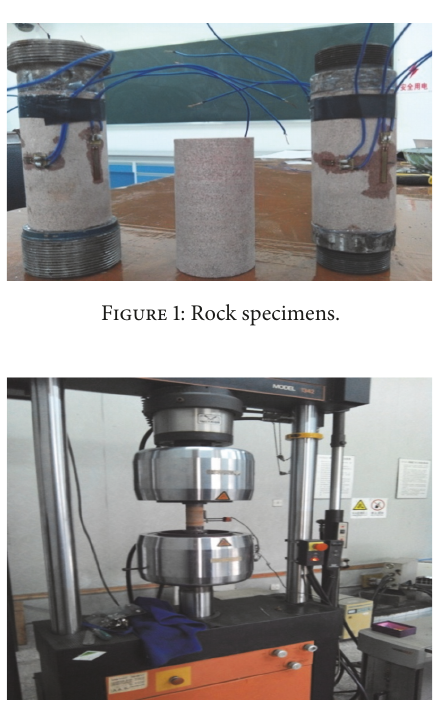
Figure 2: Experimenting machine of INSTRON